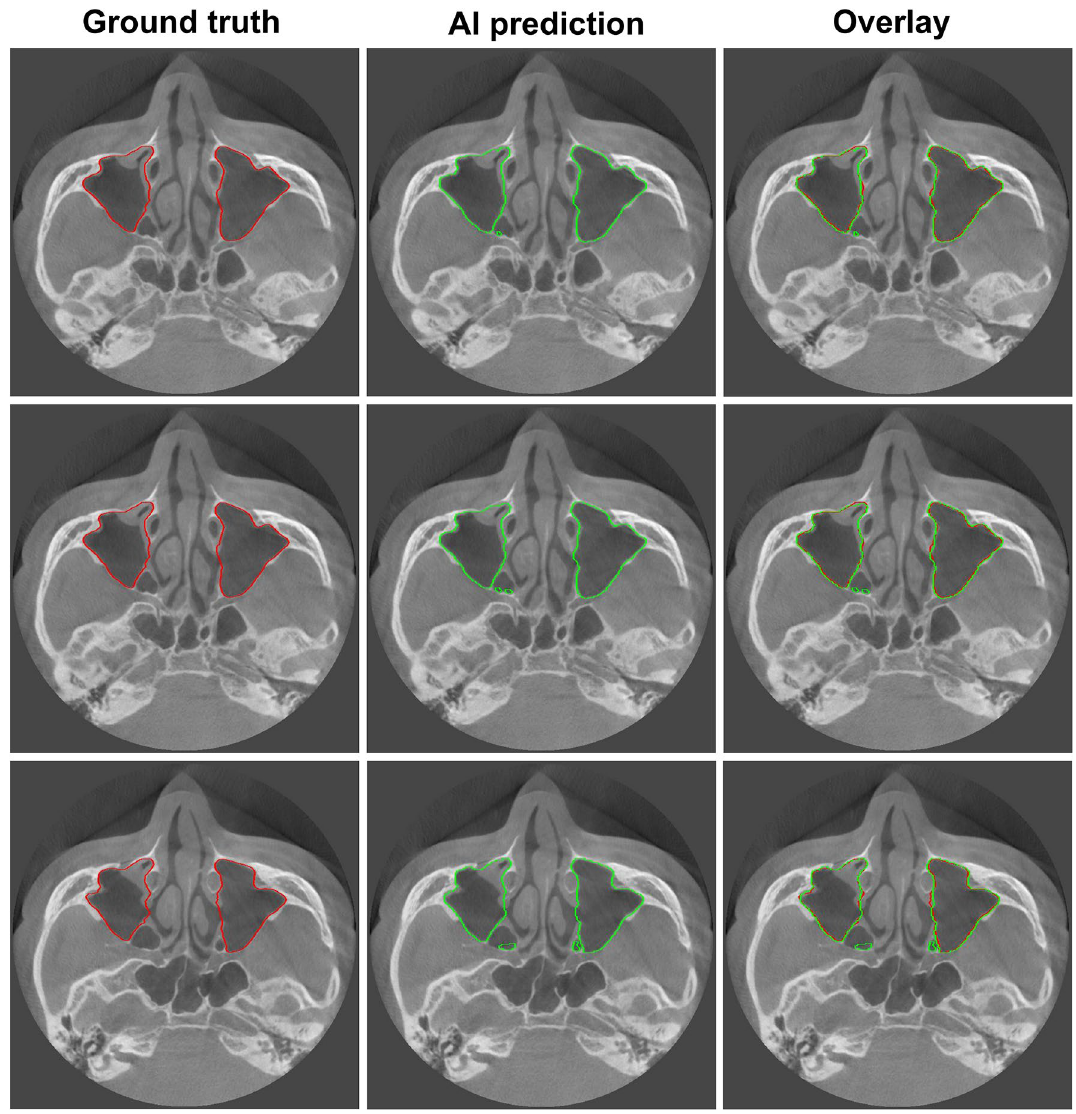
Figure 6. Worst results of maxillary sinus segmentation. The mispredicted part in the posterior part of the maxillary sinus is the ethmoid sinus. Red: the edges of the ground truth image; green: the edges of the artificial intelligence (AI) prediction